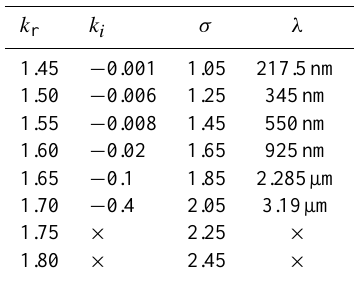
Fig. 5. Mass extinction efficiency (left) at 550nm for given values of σ and k r , k i as a function of the radius for the Mie computa- tion versus the dual polynomial interpolation and the relative error (right). Table 2. Input stored terms into the look-up tables for the polyno- mial